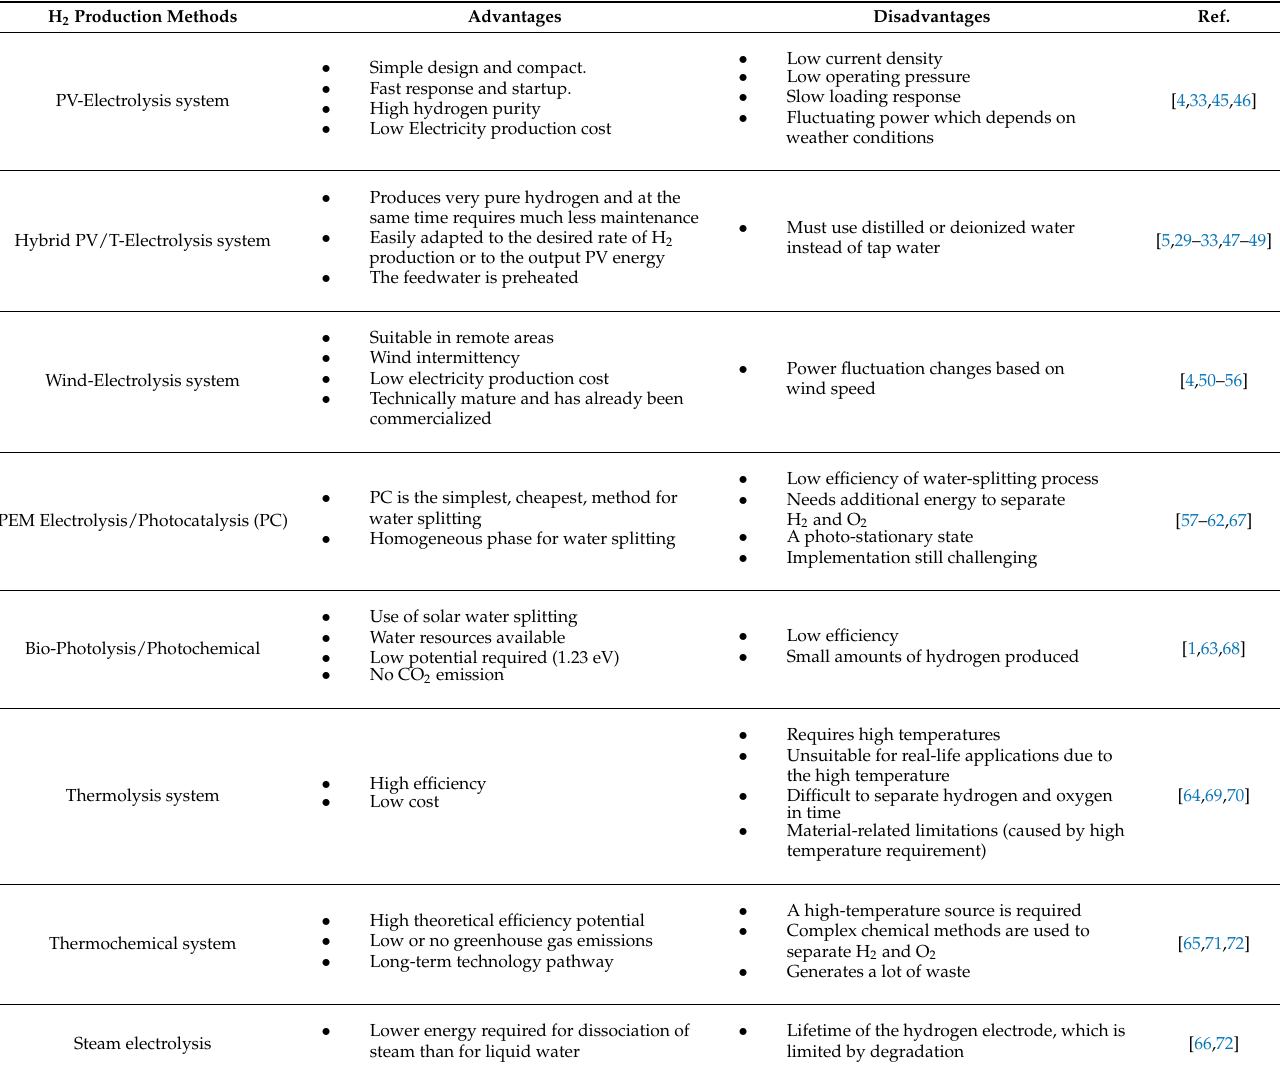
Table 4. Comparison between different methods for hydrogen production based on solar and wind